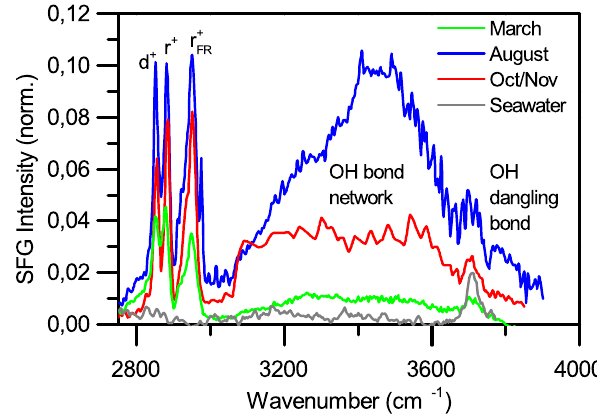
Fig. 1. Sea surface nanolayer spectra for March, August and Oc- tober/November. These three spectra are averages representing 4–6 spectra each taken over three years in the respective months. For comparison, the (non-averaged) spectrum of a surfactant-free water sample from a depth of 25 m has been included as well. The labels indicate the different vibrational